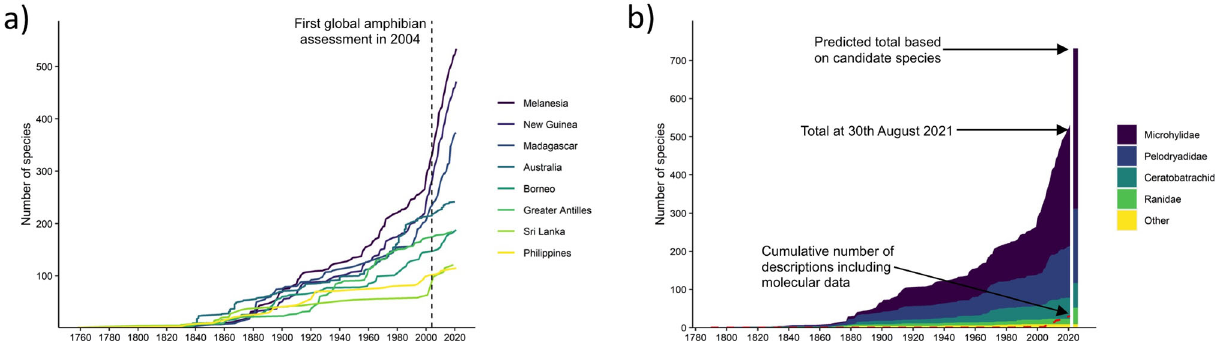
Fig. 1 Temporal trends in the documentation of the Melanesian frog fauna. a Species accumulation curves for species-rich (>100 species) insular frog biotas (Species lists from AmphibiaWeb as of 1 October 2021). Separate accumulation curves are given for the entire fauna of Melanesia (including New Guinea), and the fauna of New Guinea and nearby predominantly land-bridge islands. b Species accumulation curve for frogs within Melanesia. Bar at end indicates predicted number of species in each major family based on known, but as yet undescribed candidate species.